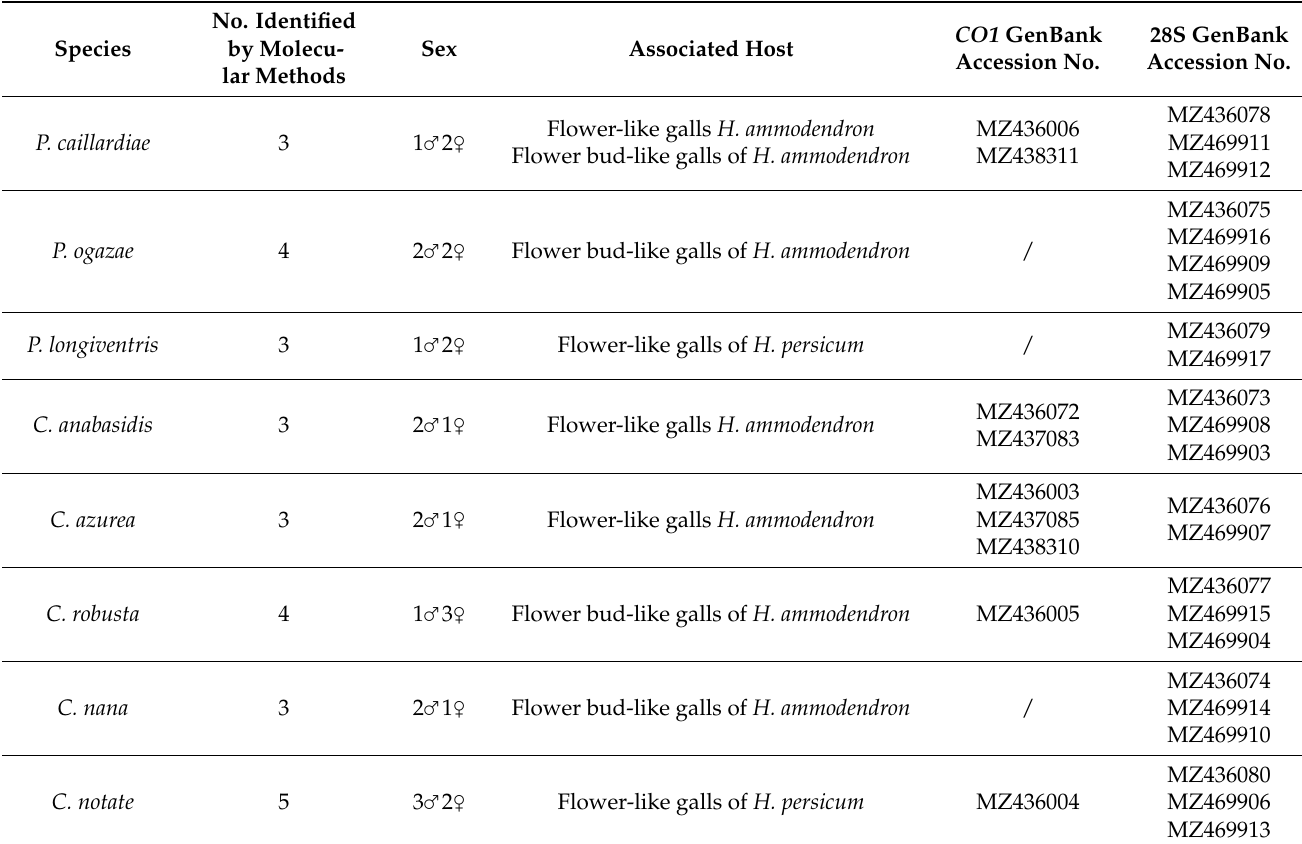
Table 4. Sampling information and GenBank accession number for the deposited sequences generated from this study.